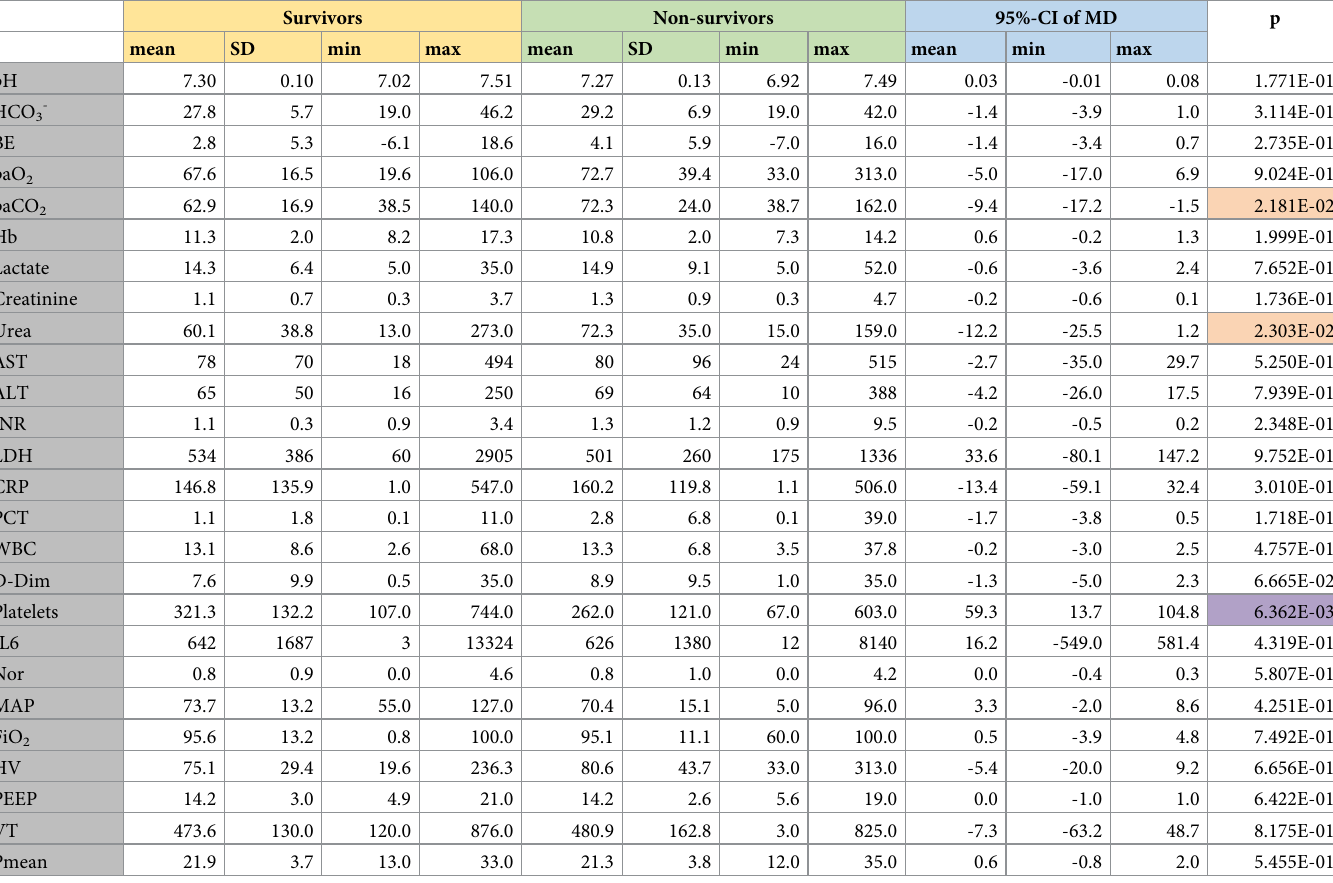
Table 1. Baseline parameters before the start of veno-venous extracorporeal membrane oxygenation (VV ECMO). Survivors Non-survivors 95%-CI of MD